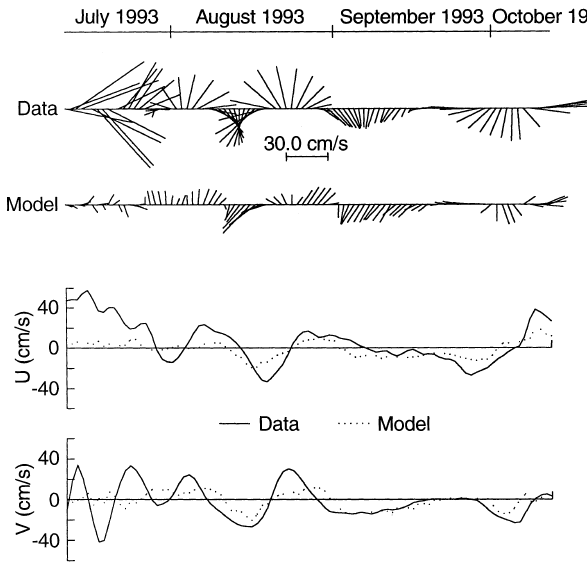
Fig. 6. Comparison of the velocities provided by the surface drifter 17543 (immersed at 150 m depth) and by the model along the drifter path. The vectorial correlation